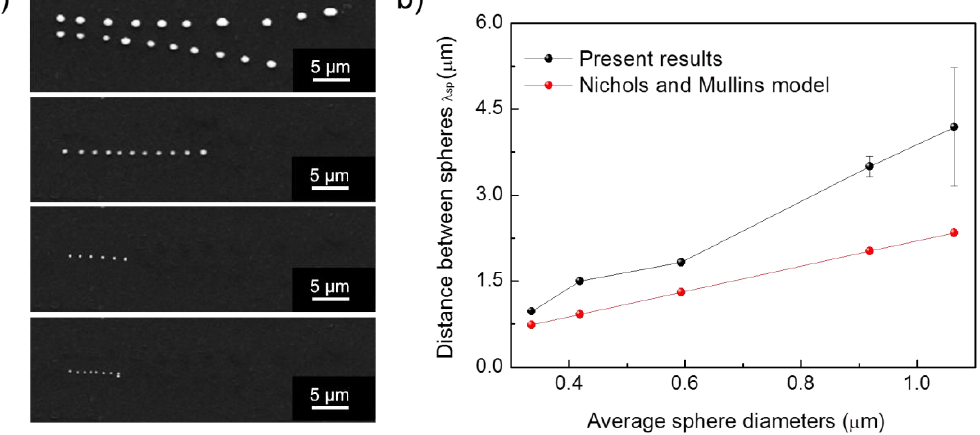
Figure 4. ( a ), Morphologies of Ag particle-chains (AgPCs) with various periodicities; ( b ), statistical and theoretical results of the relation between the Ag nanoparticles diameters and centre-to-centre distances.